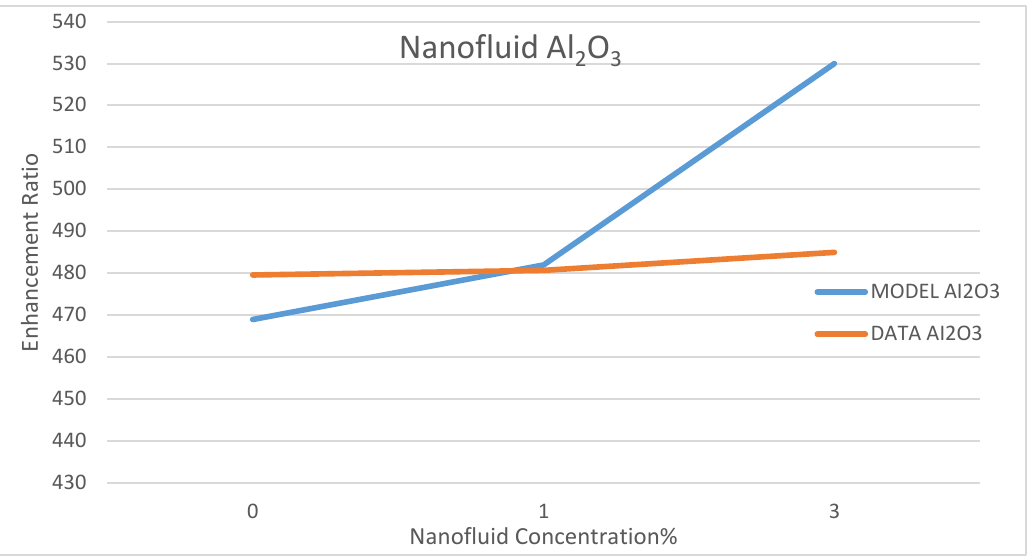
Figure 32. Comparison between model and data of Bellos and Tzivanidis [35].